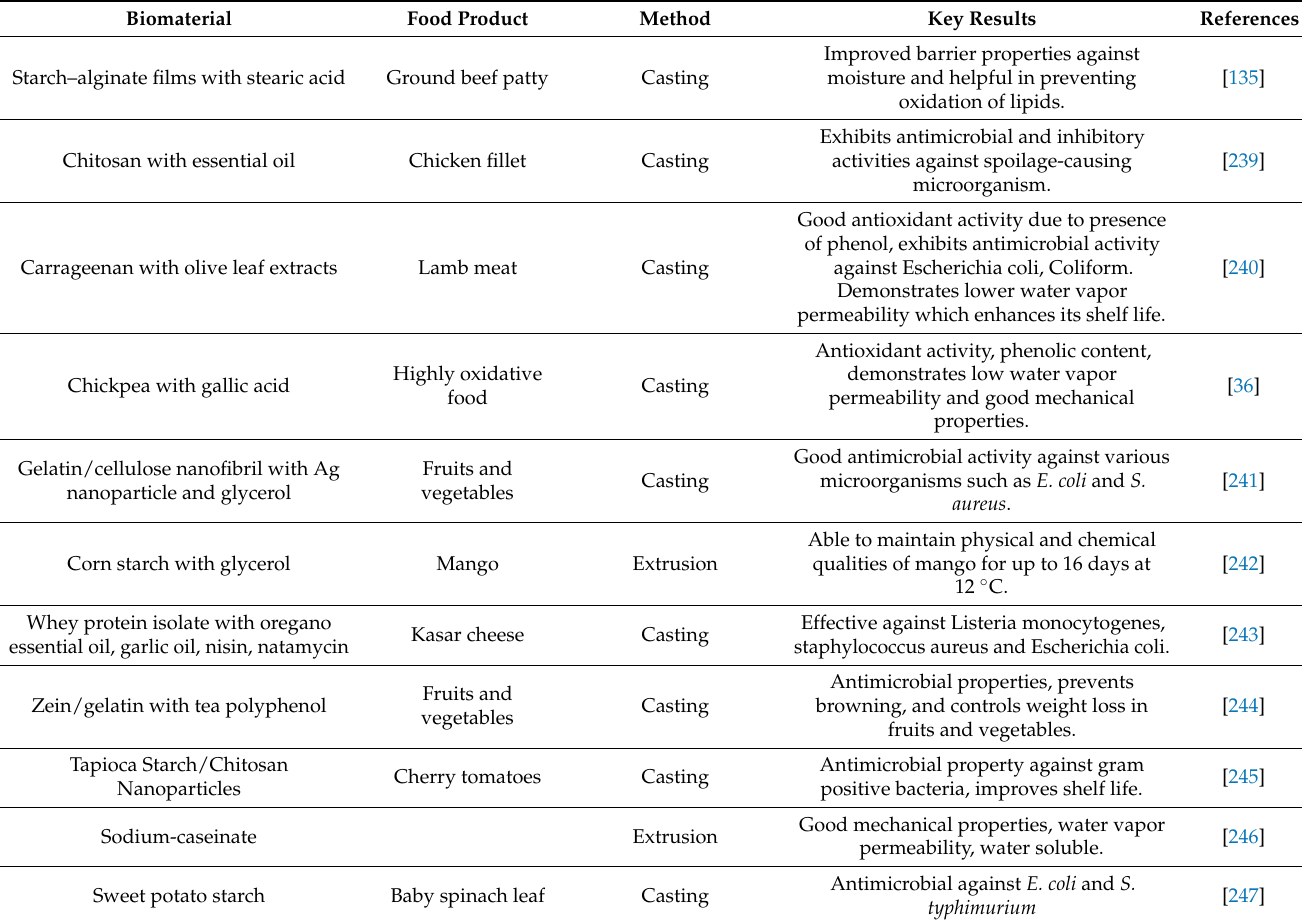
Table 4. Application of edible films included with active ingredients and their effects on food